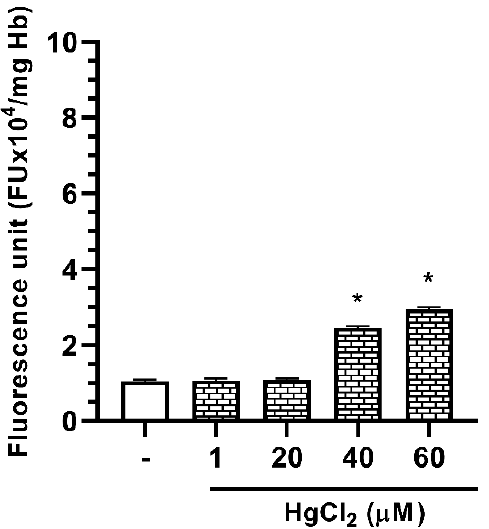
Figure 5. Effect of HgCl 2 treatment on reactive oxygen species (ROS) production in RBC. Intact RBC were exposed in vitro for 4 h to different concentrations of HgCl 2 and ROS production was evaluated by means of the fluorescent probe Dichlorofluorescein (DCF). Data are the means ± SEM (n = 9). Statistical analysis was performed with one-way ANOVA followed by Dunnett’s test (* p < 0.05).